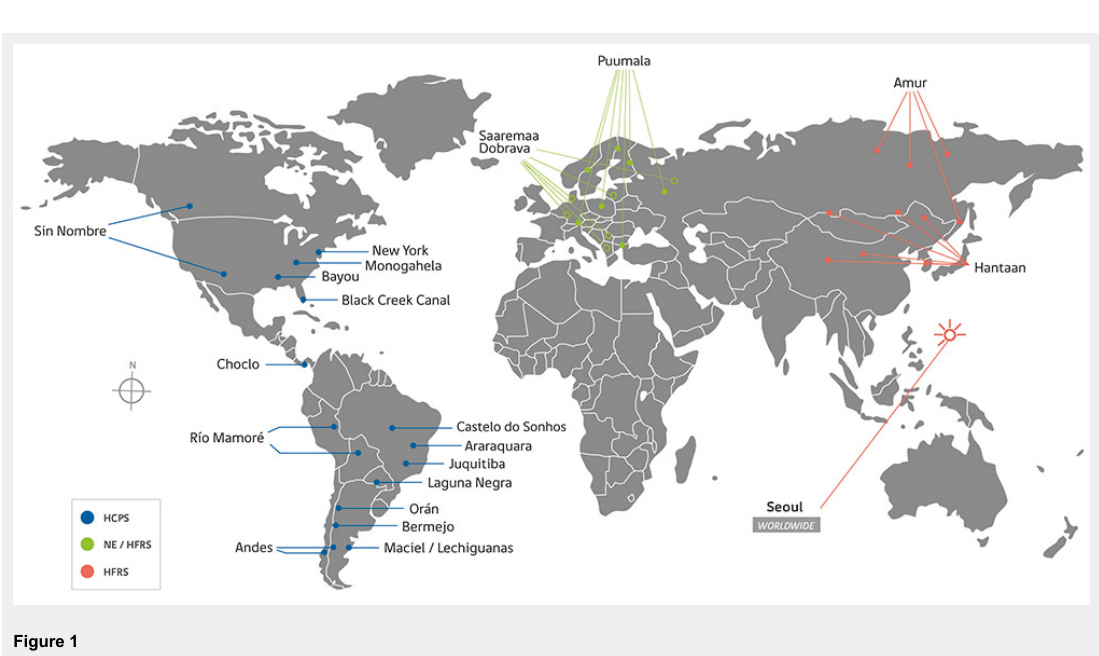
Figure 1 Geographical distribution of pathogenic hantaviruses and principal associated pathologies in humans. HCPS = hantavirus cardiopulmonary syndrome; HFRS = haemorrhagic fever with renal syndrome; NE = nephropathia